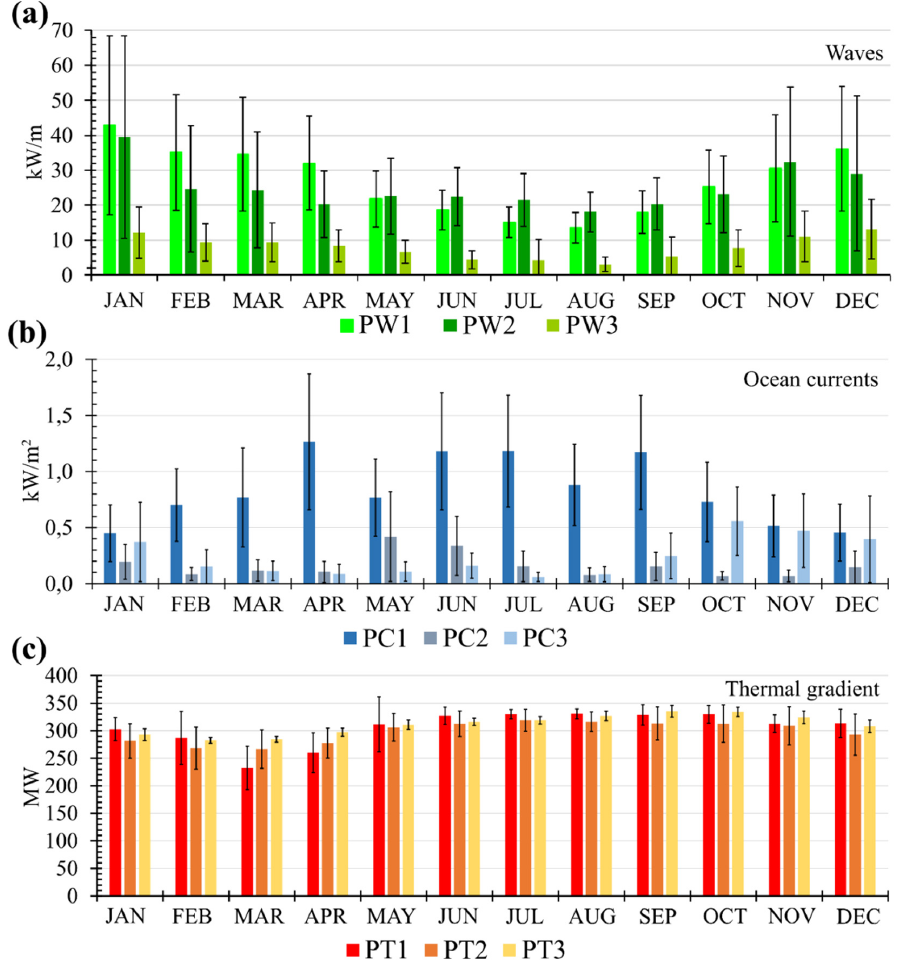
Figure 6. Monthly variations of theoretical power at particular locations. ( a ) Power from wave energy (in kW / m) at PW1, PW2, and PW3. ( b ) Power from ocean currents (in kW / m 2 ) at PC1, PC2, and PC3. (in kW/m) at PW1, PW2, and PW3. ( b ) Power from ocean currents (in kW/m 2 ) at PC1, PC2, and PC3. ( c ) Power from thermal gradient energy (in MW) at PT1, PT2, and ( c ) Power from thermal gradient energy (in MW) at PT1, PT2, and PT3.